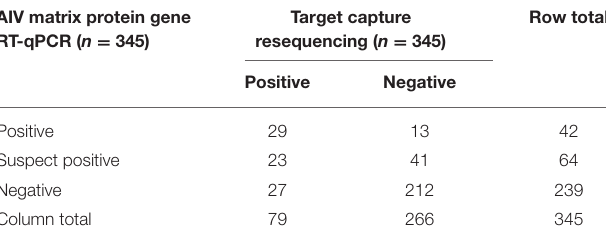
AIV matrix protein gene RT-qPCR ( n =